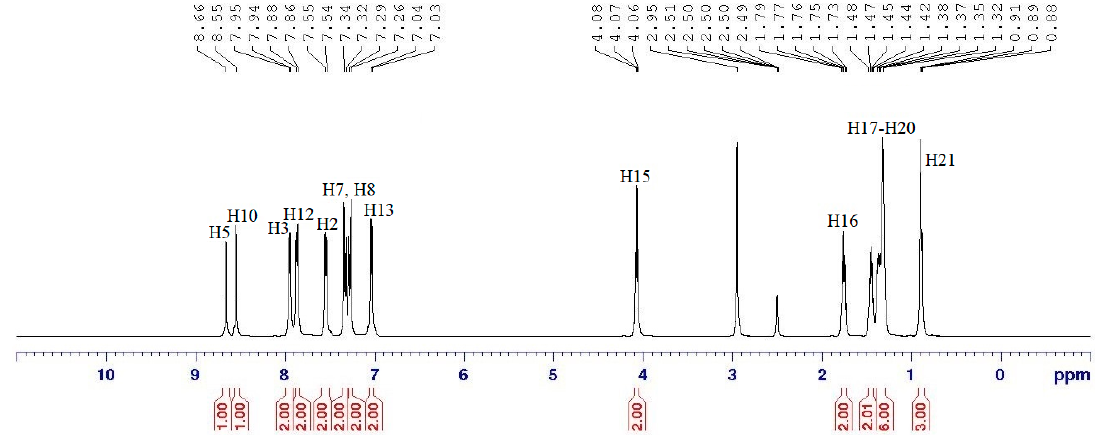
Figure 3. 1 H Nuclear Magnetic Resonance (NMR) spectrum of compound 4a .